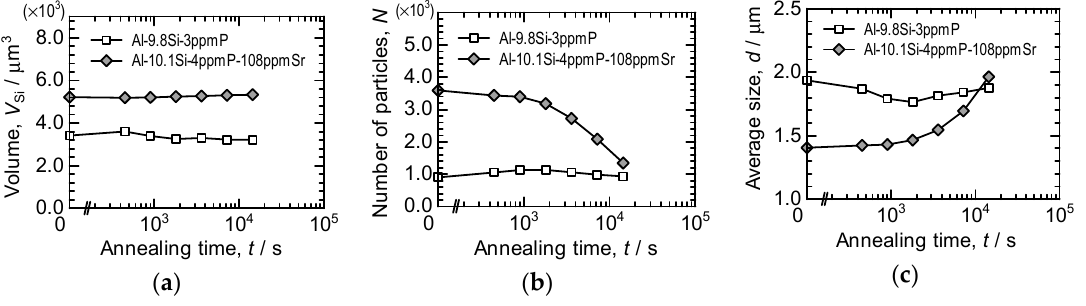
Figure 9. Changes in total Si-particle volume, number of Si-particle and average Si-particle size during heat treatment. Initial total Si-particle volume was 3416.645 μ m 3 and 5217.278 μ m 3 in Al-9.8%Si-3ppmP cast alloy and Al-10.1%Si-4ppmP-108ppmSr cast alloy, respectively. ( a ) total Si-particle volume, ( b ) number of Si-particles and ( c ) average Si-particle size.